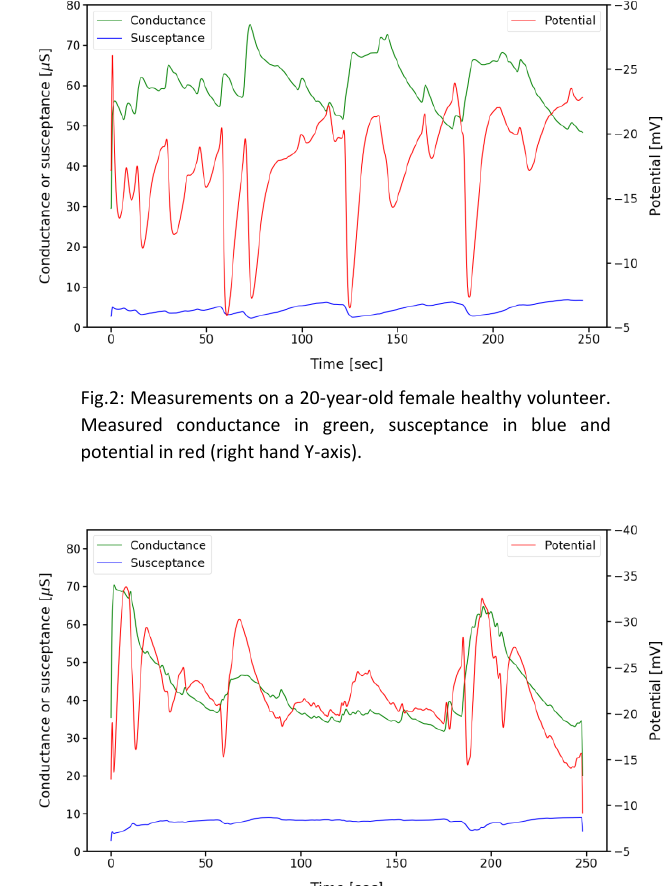
Fig.3: Measurements on a 19-year-old male healthy volunteer. Measured conductance in green, susceptance in blue and potential in red (right hand